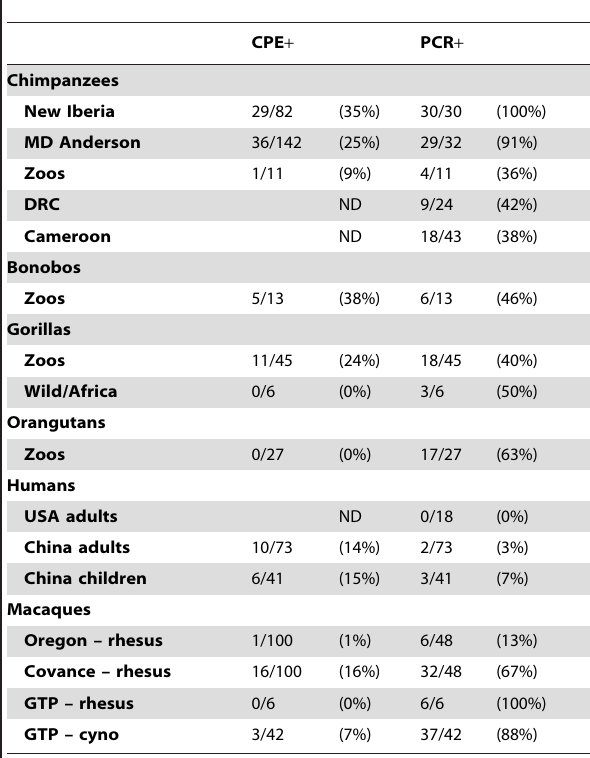
Table 1. Recovery of adenoviruses from primate